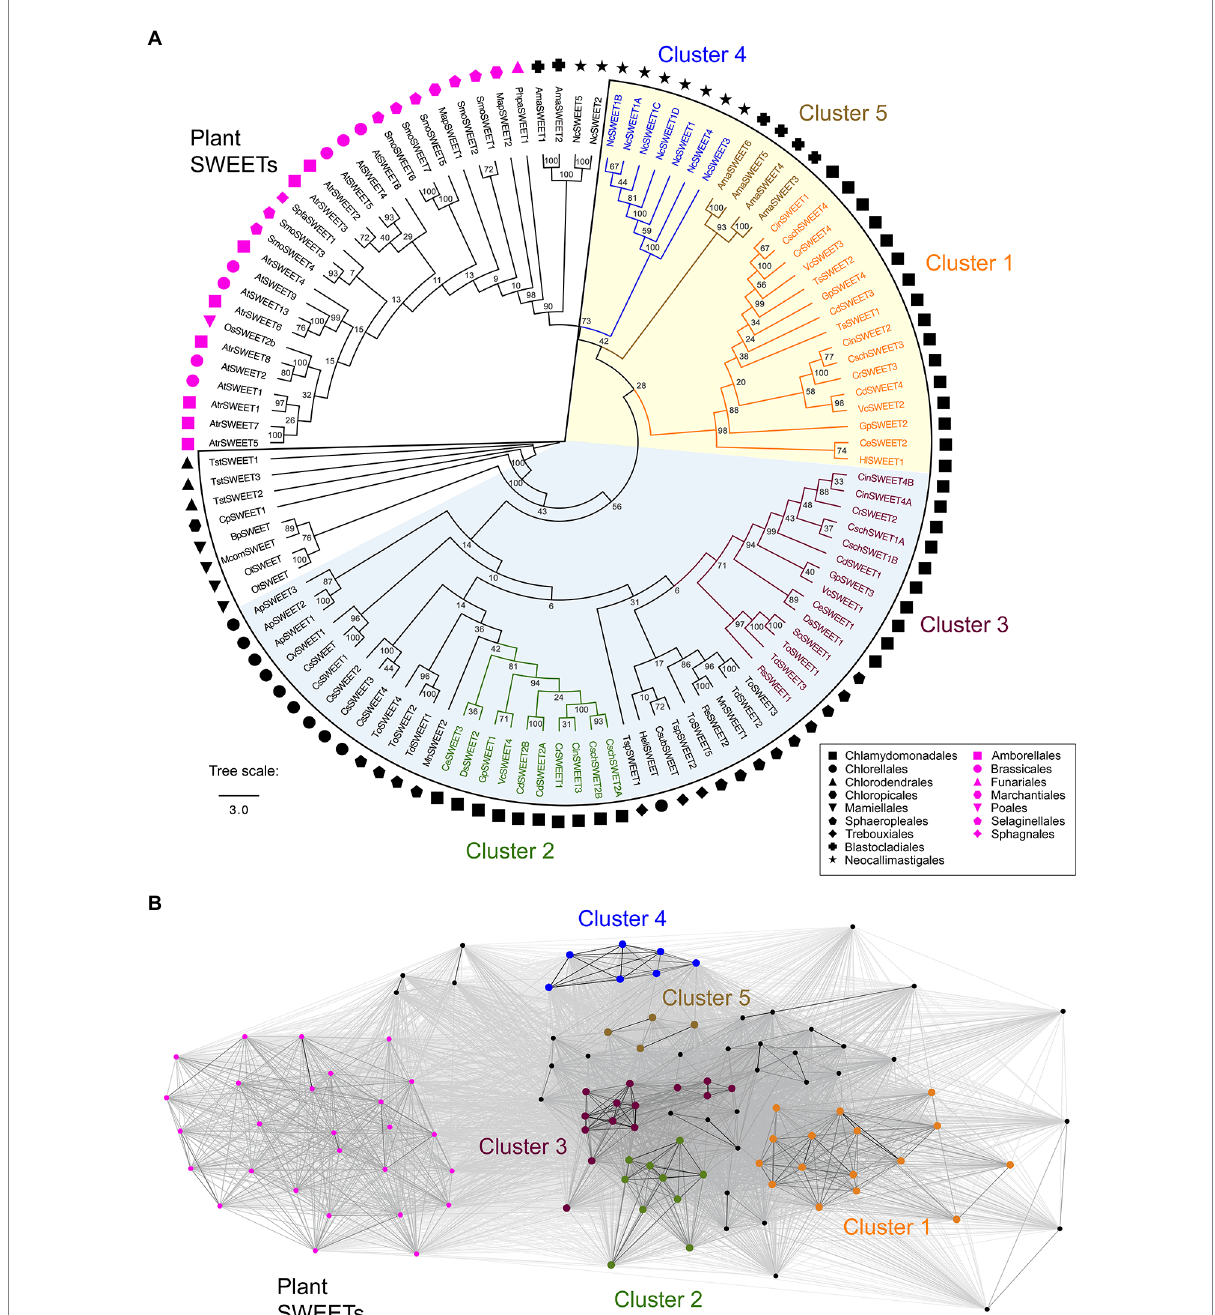
FIGURE 2 (A) Phylogenetic tree of selected Chlorophyta SWEET protein sequences and outliers from representative plants and fungi. The outlined region denotes the Chlorophyta-fungal clade although four fungal-derived SWEETs (NcSWEET2, NcSWEET5, AmaSWEET1, AmaSWEET2) sit outside the clade. Symbols indicate the taxonomic orders of the species where the protein sequence is derived. A consensus maximum likelihood tree following bootstrap replications is shown. The Chlorophyta-fungal clade can be further divided into two sub-clades, determined on the basis of bootstrap percentage values shown at each node, and denoted by the shaded sections of the tree. Algae-fungi SWEETs that form distinct clusters, determined on the basis of CLANS analysis, are highlighted and labelled. The branch length scale bar indicates the evolutionary distance of amino acid substitutions per site. (B) A two-dimensional cluster analysis of the SWEET sequences used for the phylogenetic tree was performed using CLANS. Each symbol represents one of the SWEET proteins and is coloured on the basis of the phylogenetic groups shown in Panel A. Grey lines represent protein connections with reciprocal BLAST hits at p < 10 − 5 . A version of Panel B showing the names of the un-clustered proteins is shown in Supplementary Figure 2. The full list of SWEET sequences and their identification numbers is shown in Supplementary Table